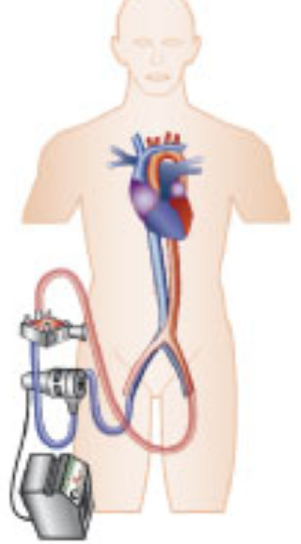
Figure 1. Basic overview VA-ECMO.